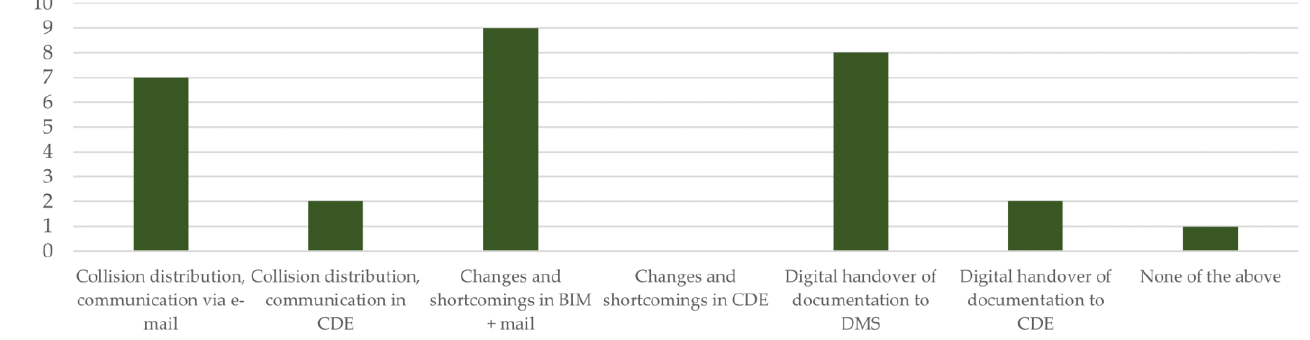
Figure 10. Responses to the question: “Which of the following tasks have been done by your team in the project?—part